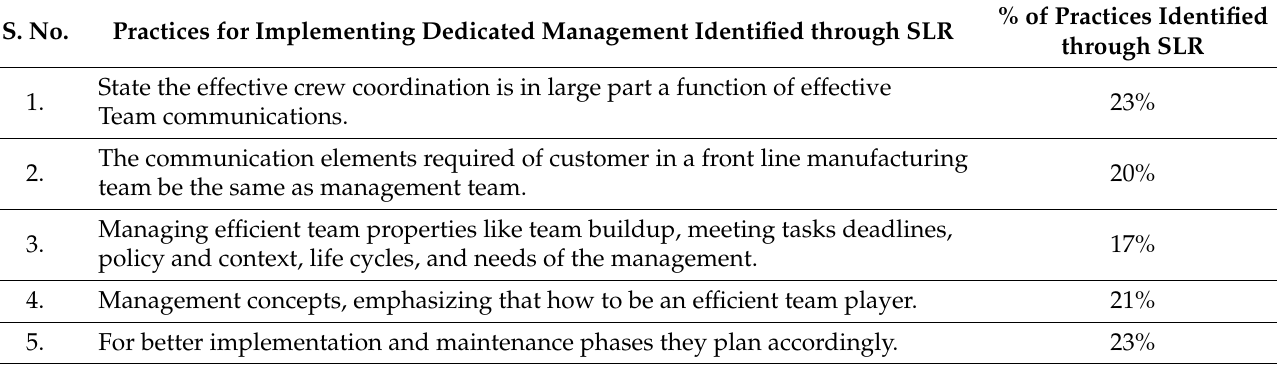
Table 6. Practices for implementing dedicated